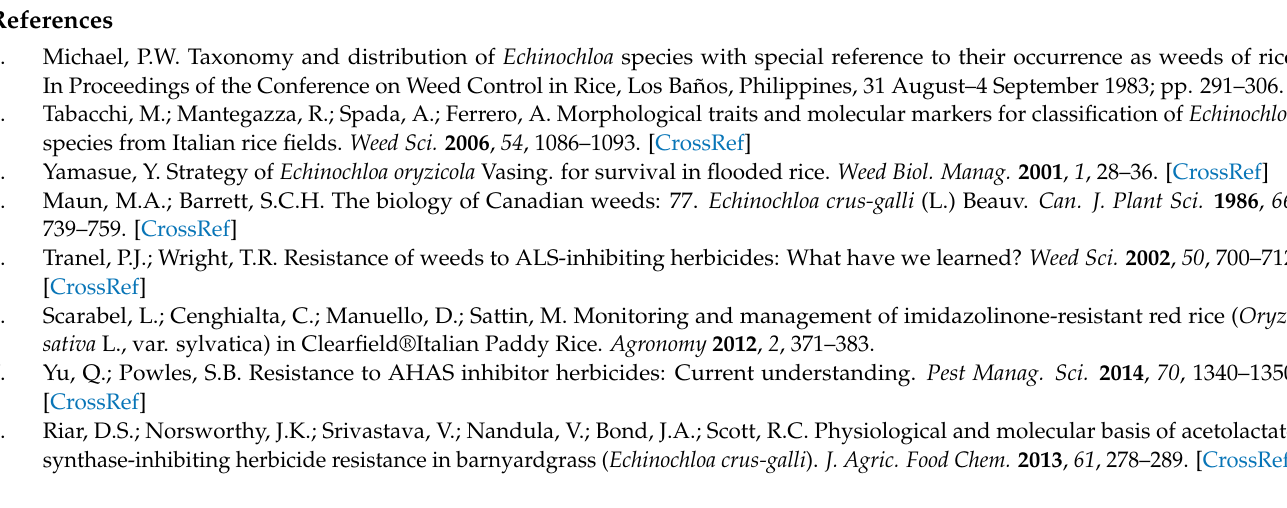
Figure S2: Morphological characteristics used to distinguish Echinochloa species, Figure S3: Results of screening test on susceptible populations, Figure S4: Results of screening test on resistant populations, Figure S5. Scheme of gDNA-based molecular marker CAPS-rbcL, Figure S6: Results of the first two Southern blotting analyses, Figure S7: Cladogram including sequences from both E. crus-galli and E. oryzicola populations, Figure S8: qPCR results for reference genes, Figure S9: Ct of reference genes amplified on the different populations included in the experiment, Figure S10: Digestion with the endonuclease FokI, Figure S11: qPCR results for ALS